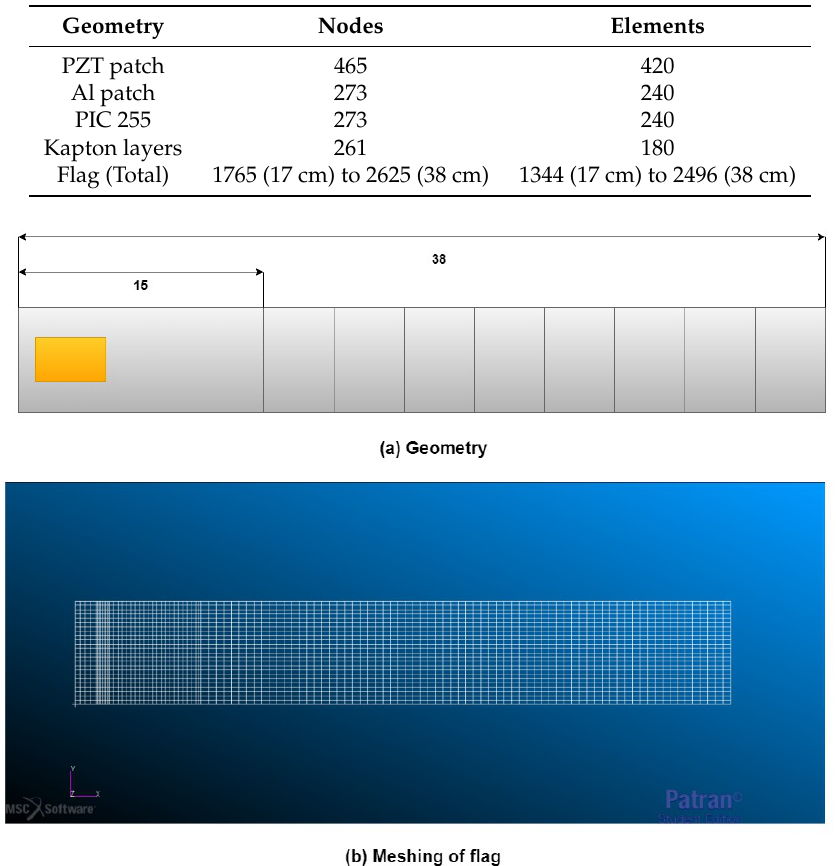
Table 4. Nodes and elements for discretization.